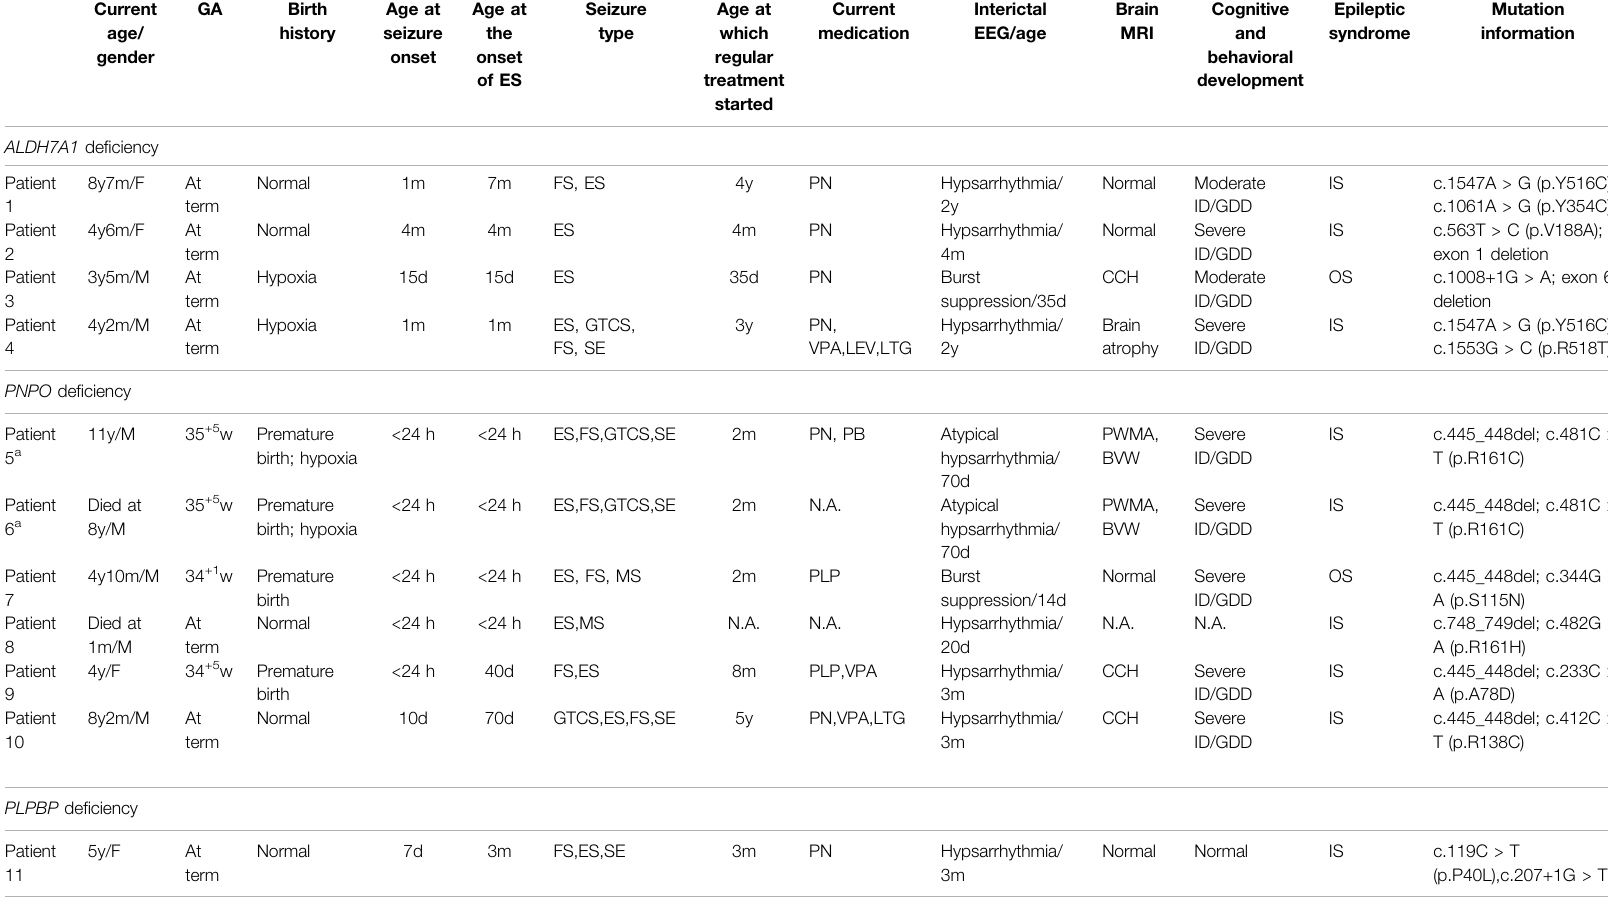
TABLE 1 | Clinical characteristics and genetics of 11 patients with the presentation characterized by epileptic